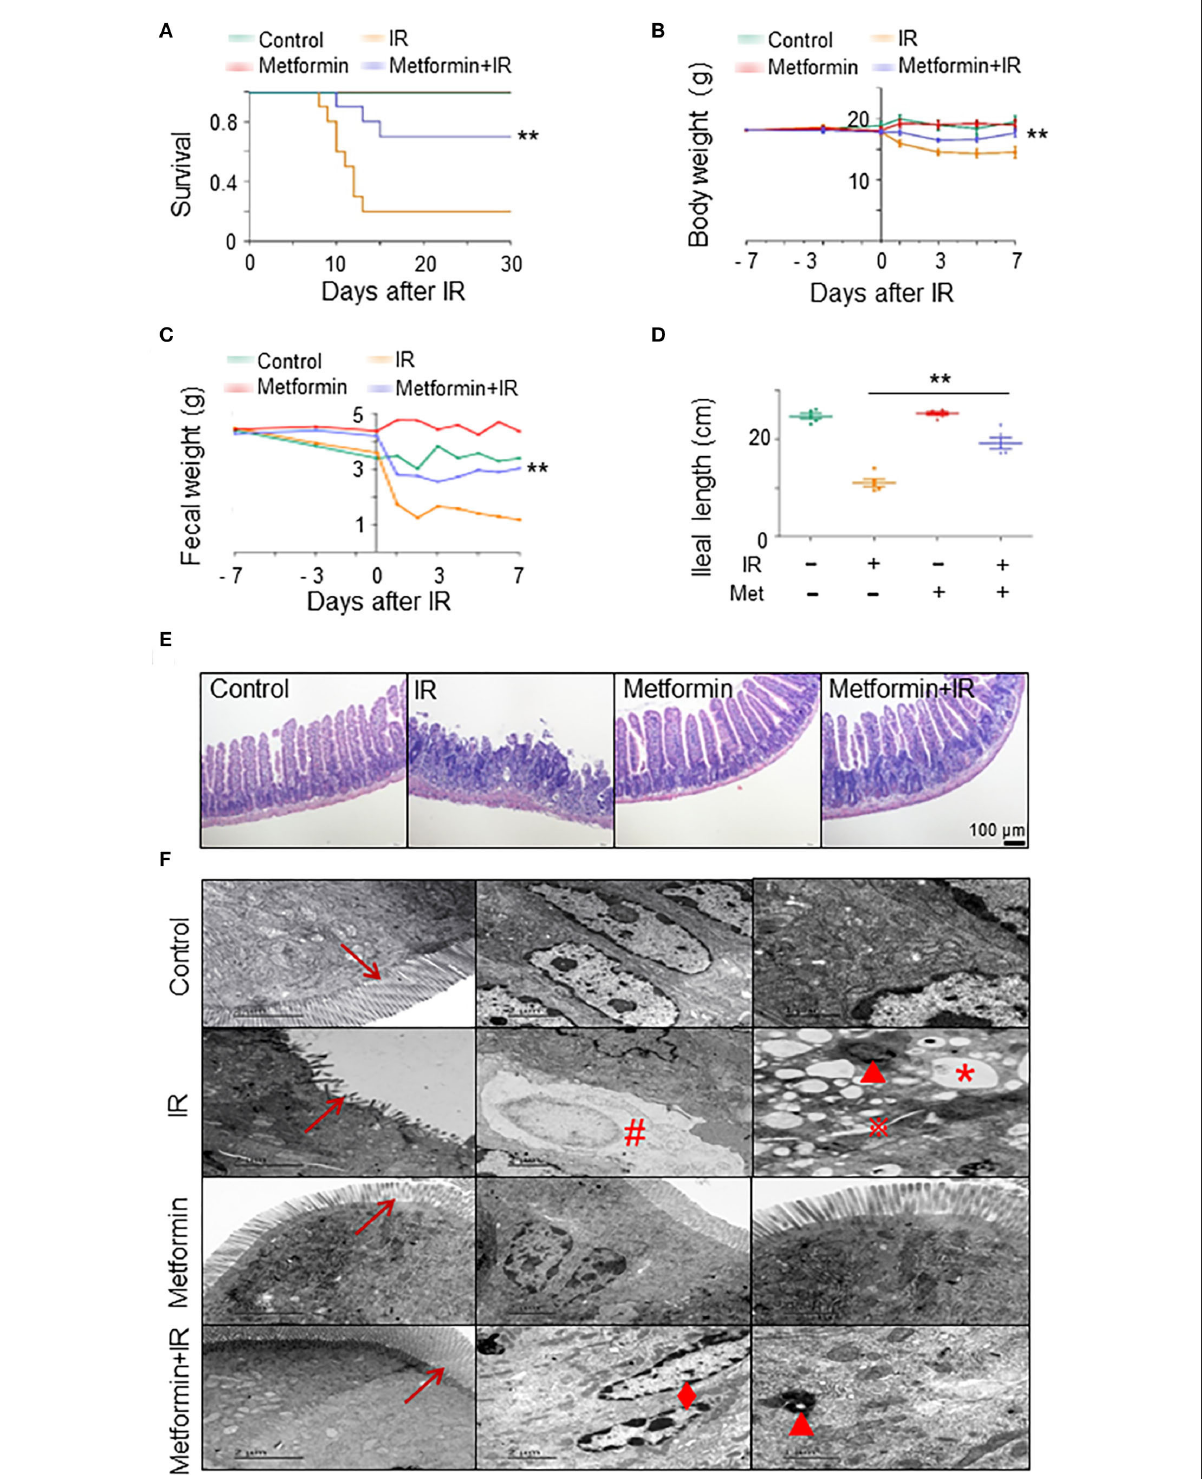
FIGURE1 Metformin mitigates intestinal damage in IR mice. Metformin was intragastrically administered to mice at a dose of 250 mg/kg/day. Each mouse was administered continuously for 7 days before and 3 days after radiation for a total of 10 days. Mice were given 8Gy one-time abdominal IR with a dose rate of 1.0 Gy/min in an X-ray radiation source or a mock treatment. Ilea were collected for light and electron microscopy 3 days